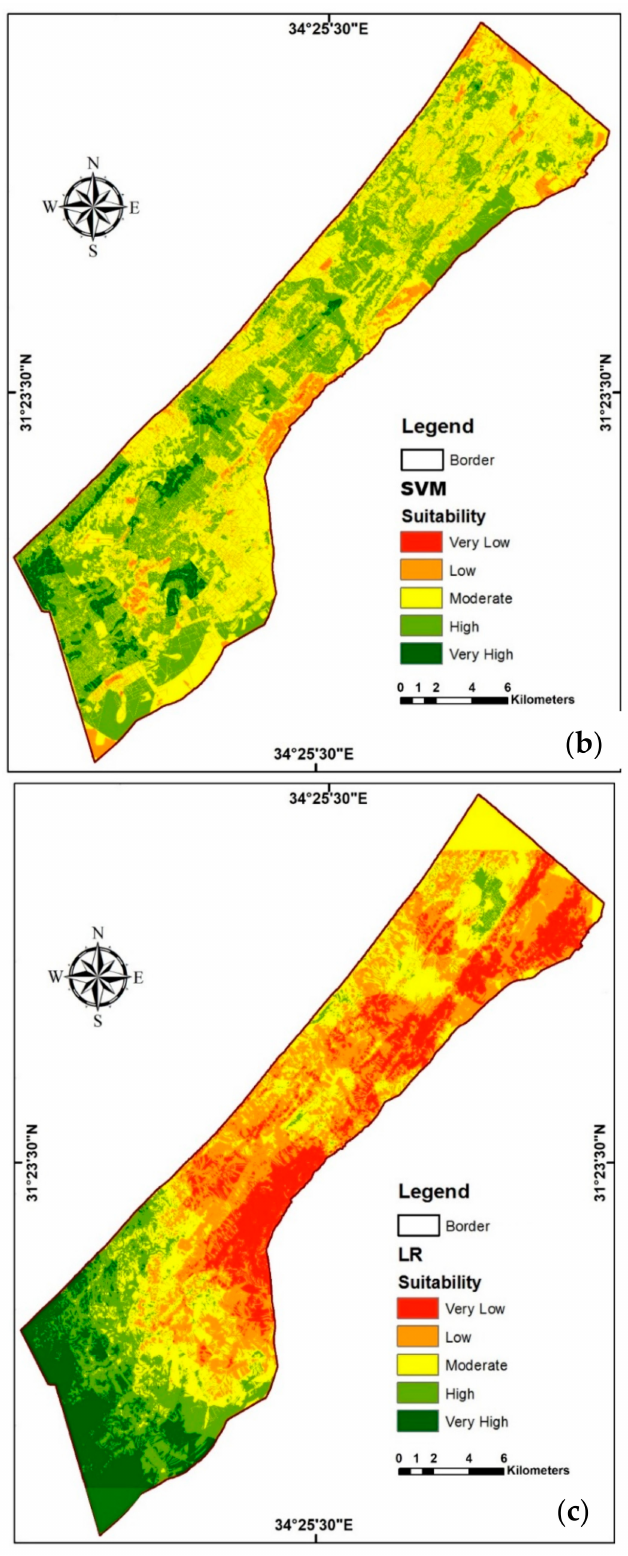
Figure 6. Suitability map produced using ( a ) multilayer perceptron, ( b ) support ector machine, and ( c ) linear regression